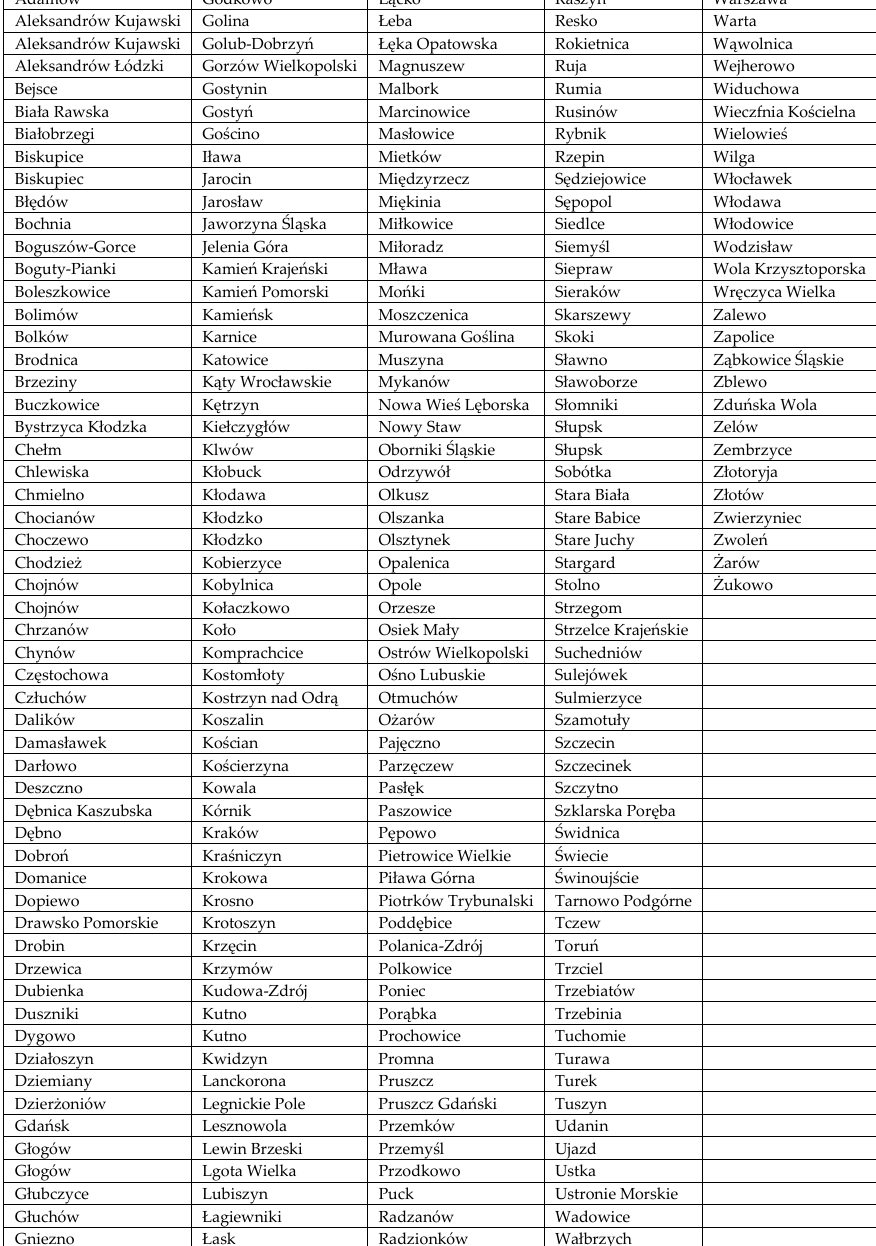
Figure A1. Municipalities with adopted spatial plans for wind power plants.